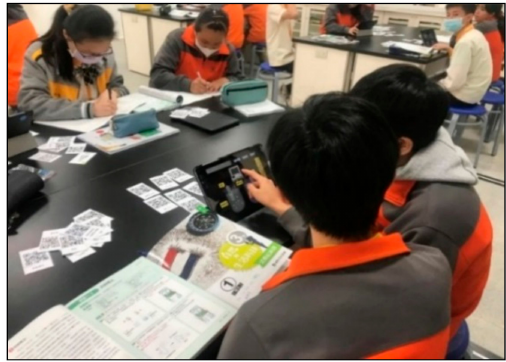
Figure 11. Experimental group conducting the virtual experiment.